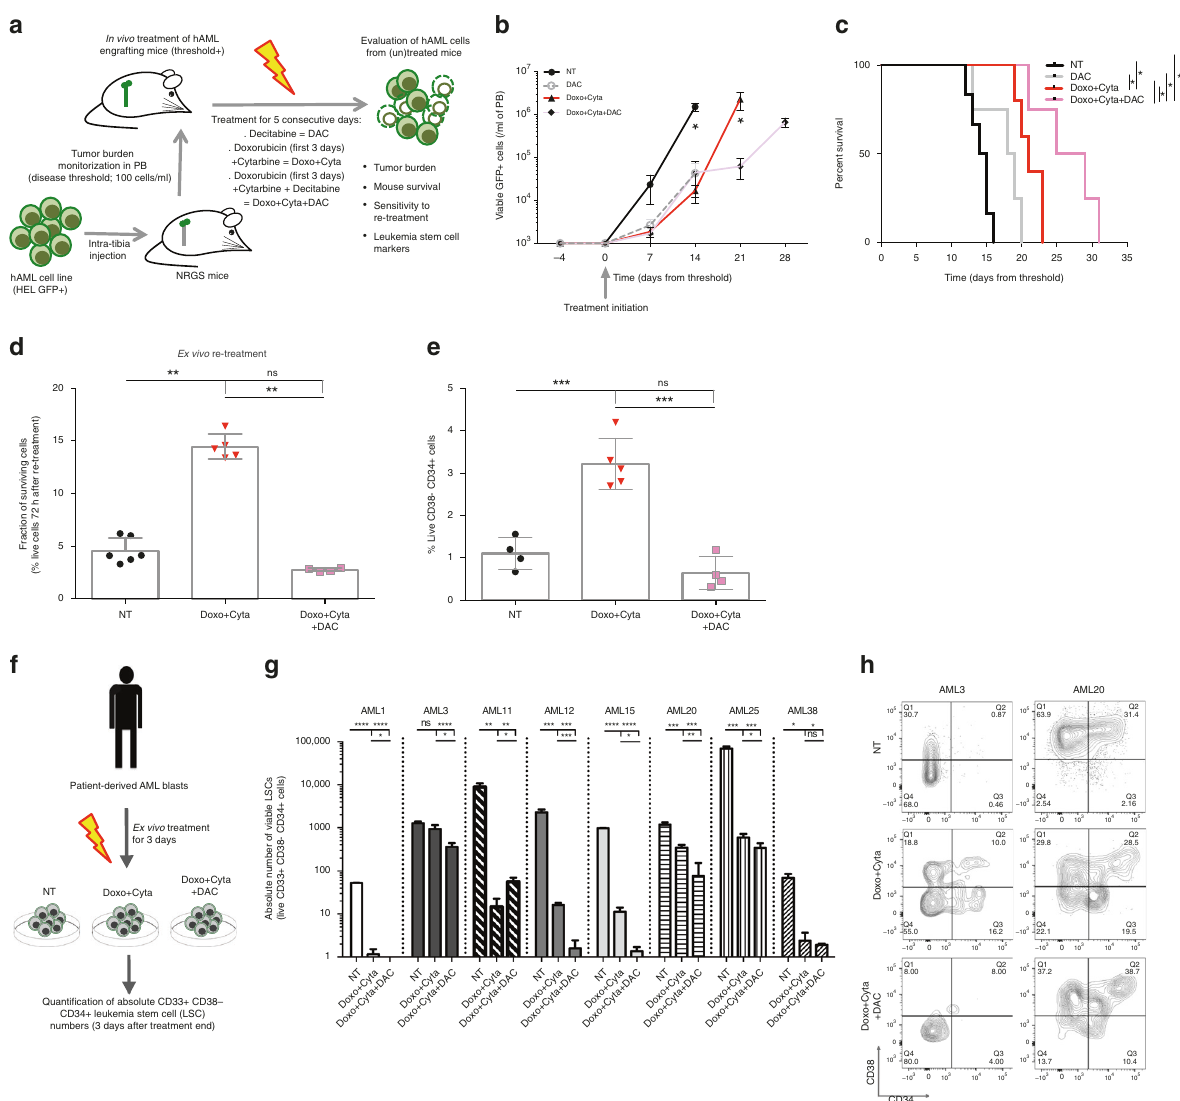
Fig. 6 Decitabine combination depletes LSCs from xenografts and AML patient samples. a Schematic diagram of the therapeutic setting used to treat NRGS mice bearing human AML (GFP + HEL) cells. Chemotherapy regimen (Doxo + Cyta): intraperitoneal (i.p.) injection of cytarabine (100mg/kg per day over 5 days) and doxorubicin (3mg/kg per day over the fi rst 3days). Decitabine combination was initiated 2 days after Doxo + Cyta, via i.p. injection of 0,5mg/kg DAC for 5 consecutive days. b The total number of viable hAML HEL (GFP + , 7AAD-) cells in peripheral blood (PB) and mouse survival ( c ) in untreated (NT, n = 6), DAC alone ( n = 4), Doxo + Cyta ( n = 5) and Doxo + Cyta + DAC ( n = 4) groups. d Frequency of viable BM-sorted hAML cells, sorted from the BM of mice from the three groups described in b , c , after ex vivo exposure to Doxo + Cyta for 72h. e Frequency of CD38-CD34 + cells (left axis, n = 4 – 8) on BM-sorted hAML cells from indicated groups. f Schematic diagram depicting ex vivo treatment of AML patient samples Doxo + Cyta and Doxo + Cyta + DAC and the subsequent quanti fi cation of immunophenotypically de fi ned LSCs. g Absolute number of LSCs (live CD33 + CD38 − CD34 + cells) after ex vivo exposure to Doxo + Cyta and Doxo + Cyta + DAC ( n = 3 per sample). h Representative fl ow cytometry contour plots of CD38/CD34 staining gated on CD33 + VioletZombie- population. Graphs of mean±s.d., P values were determined by one-way ANOVA test. Survival curve analysis was performed by Log-rank (Mantle-Cox) testing. ns — not signi fi cant, * P <0.05; ** P <0.01; *** P <0.001; **** P <0.0001. Source data are provided as a Source Data fi